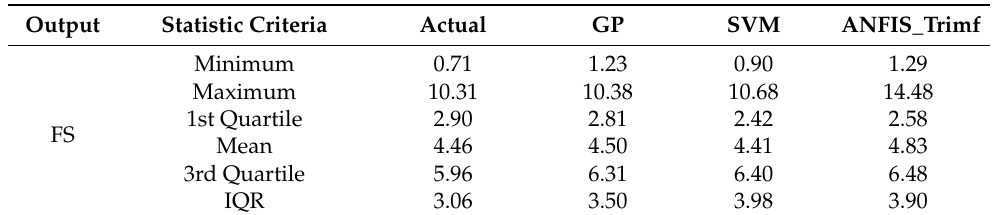
Table 10. Statistics of observed and predicted output of testing dataset utilizing soft computing algorithms.